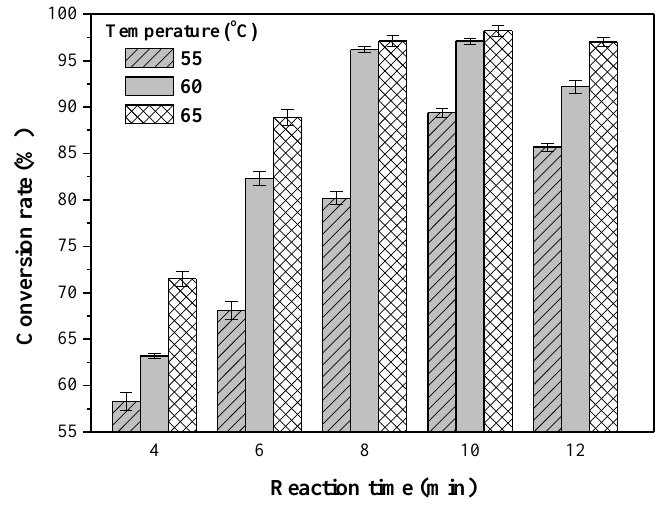
Figure 5. Effects of reaction time and reaction temperature on the transesterification reaction.